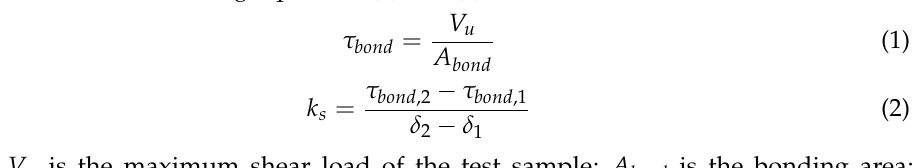
Figure 3. ( a ) Test setup, ( b ) direction of applied load, ( c ) shear plane for PER con fi guration. The bond strength τ bond and bond sti ff ness k s are two important parameters that were obtained from the tests using Equations (1) and (2).